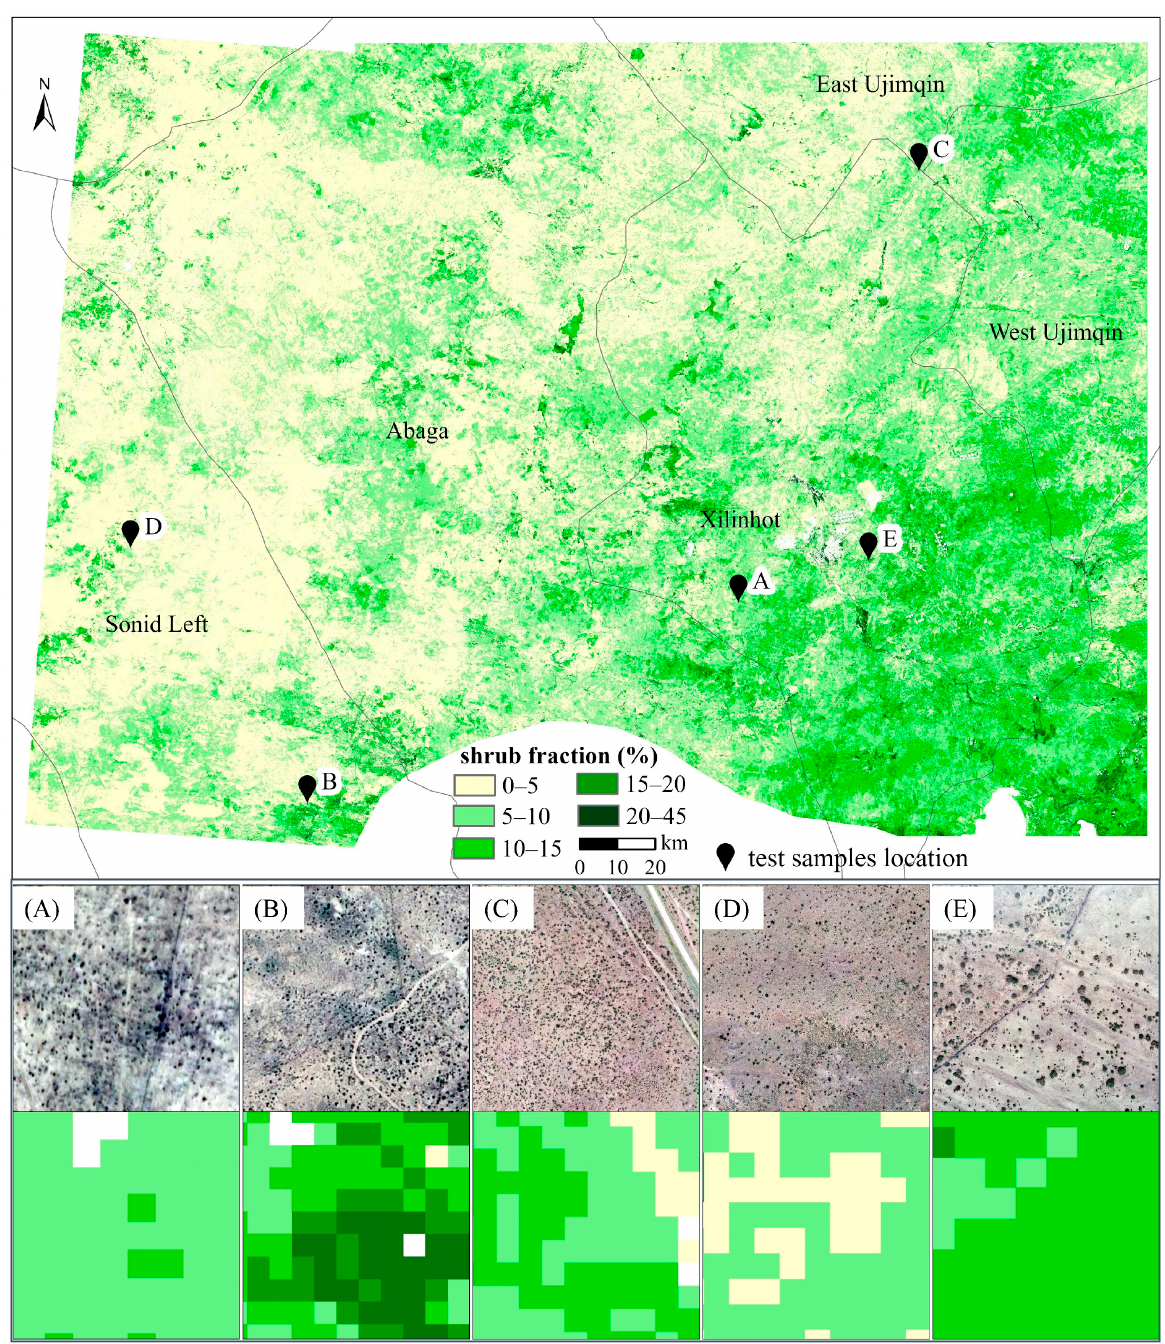
Figure 10. The shrub coverage mapping result at 20 m resolution ( upper ), and the comparison of high spatial resolution images at locations A–E ( middle row ) and the predicted shrub coverage of the test samples at above locations ( bottom row ).